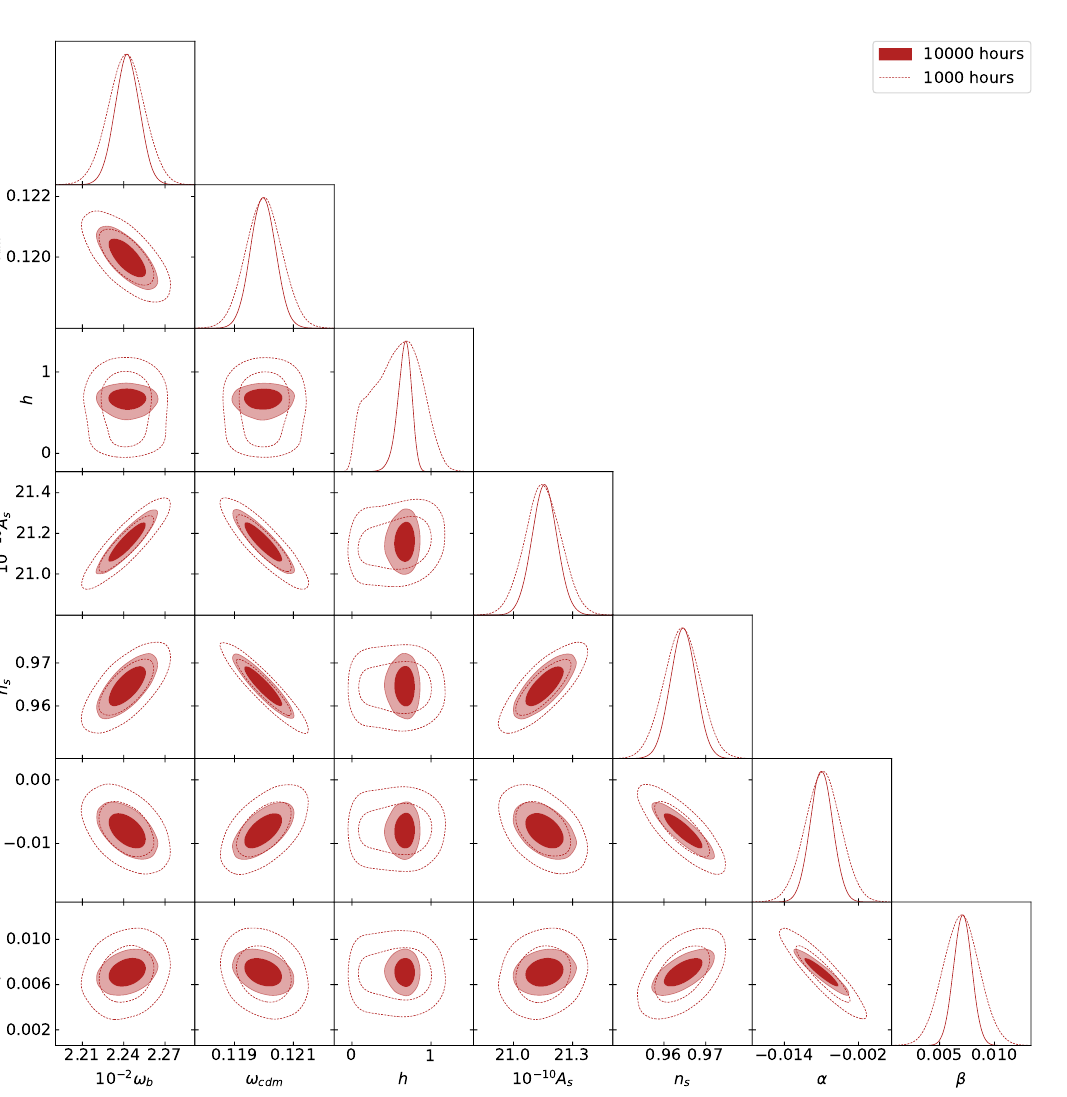
Figure 14: The contours for SKA likelihoods (red) and overlaid SKA with lower ob- servation time of 1000 hours (red dashed lines).